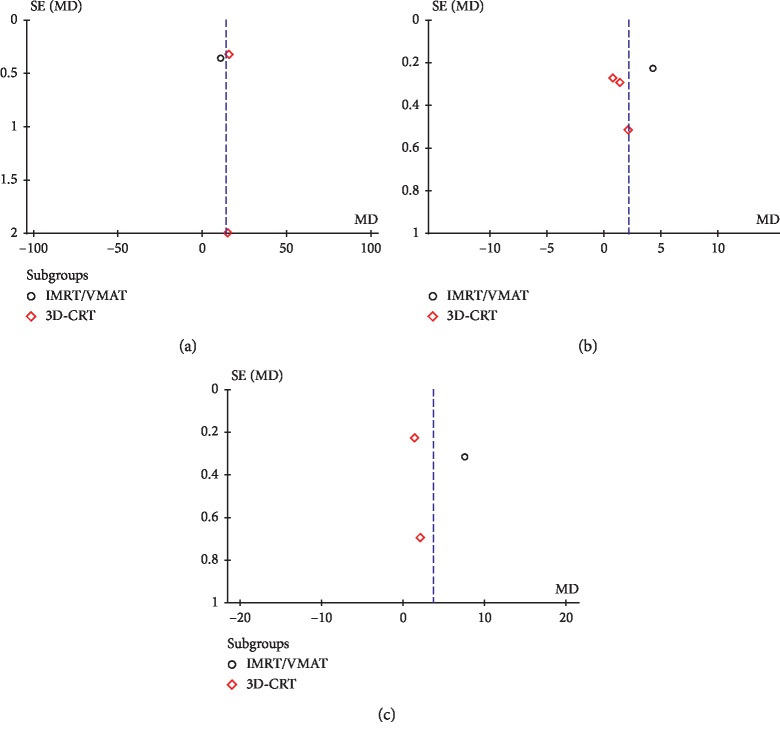
Funnel plots for extracranial OARs. (a) Dmean of the esophagus. (b) Dmean of the lungs. (c) Dmean of the kidneys.